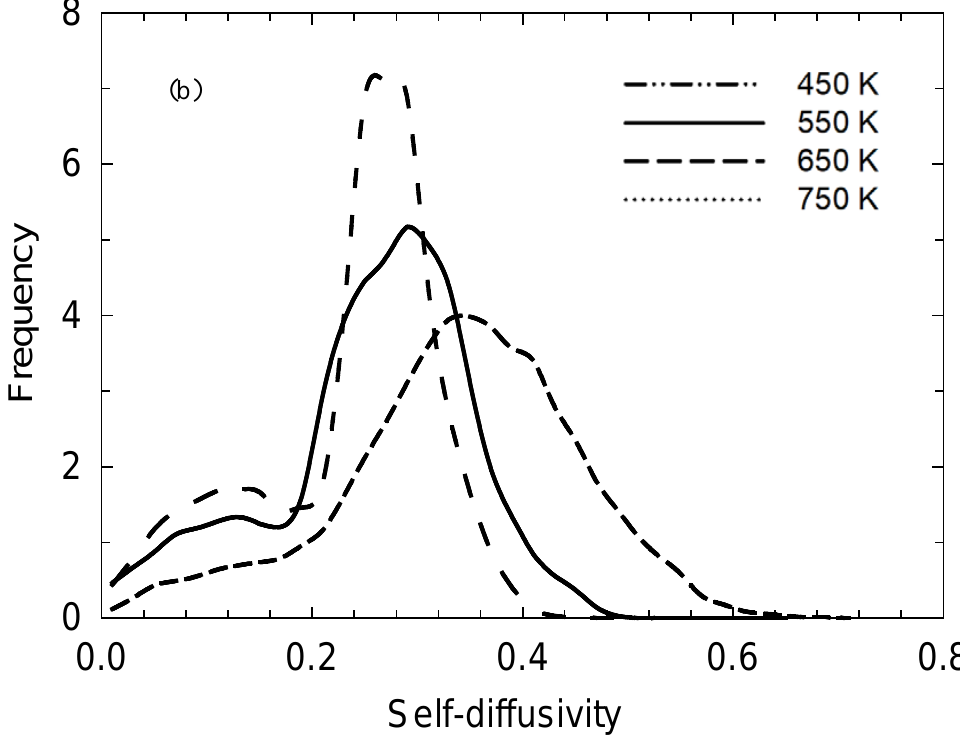
Figure 3. ( a ): Mean squared displacement (MSD) of the iodine atoms sampled over 10 ns, with log-log plot showing long-time/limiting slopes of ~0.9 and above, indicating the establishment of near-Fickian diffusion; Fickian diffusion results in a limiting log—log slope of unity. ( b ) Normalised probability distributions of individual iodine atoms’ self-diffusivities sampled from individual-atom MSDs’ limiting slopes over 0.25 ns periods. Here, depending on temperature, the sampling time is ~20–150 times the reaction events’ timescales, allowing for instances of lower diffusivities to be seen rather dramatically at 450 and 550 K with the “hump”, or shoulder, in the 0–0.2 × 10 − 9 m 2 /s region clearly evident when motion is slowed due to participation in bond-exchange reactions.